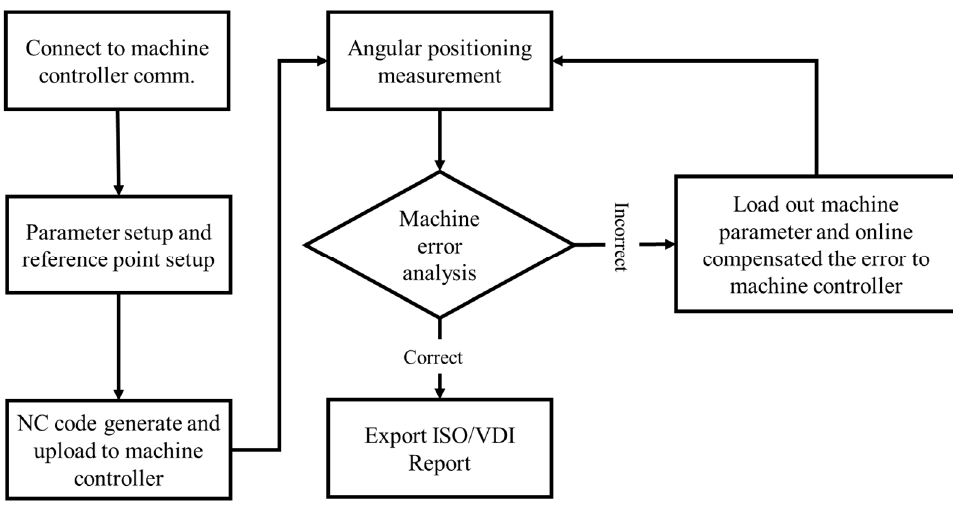
Figure 17. The angular positioning measurement process on the rotary axis after the process of the compensating error translational axes.